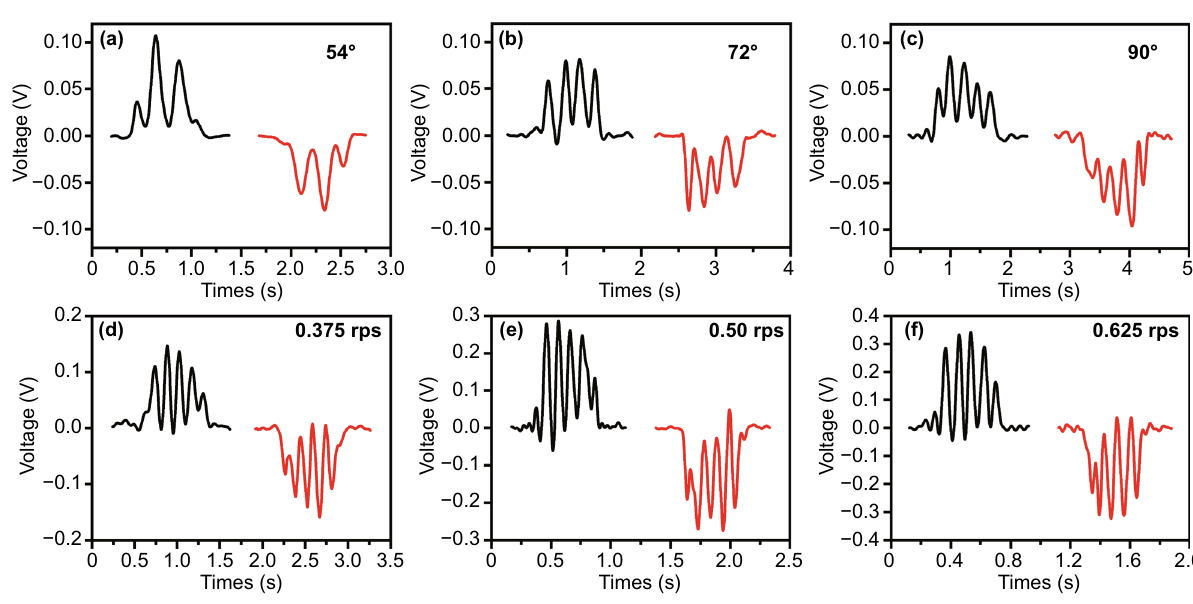
Fig. 3 Characterization of the basic performance of Ma-s-TS. a–c Pulses produced from a Ma-s-TS when rotate through different angles (54°, 72°, and 90°) at rotation speed of 0.375 rps. d–f The pulses generated from a Ma-s-TS when rotate through 90° at different rotation speed (0.375, 0.50, and 0.625